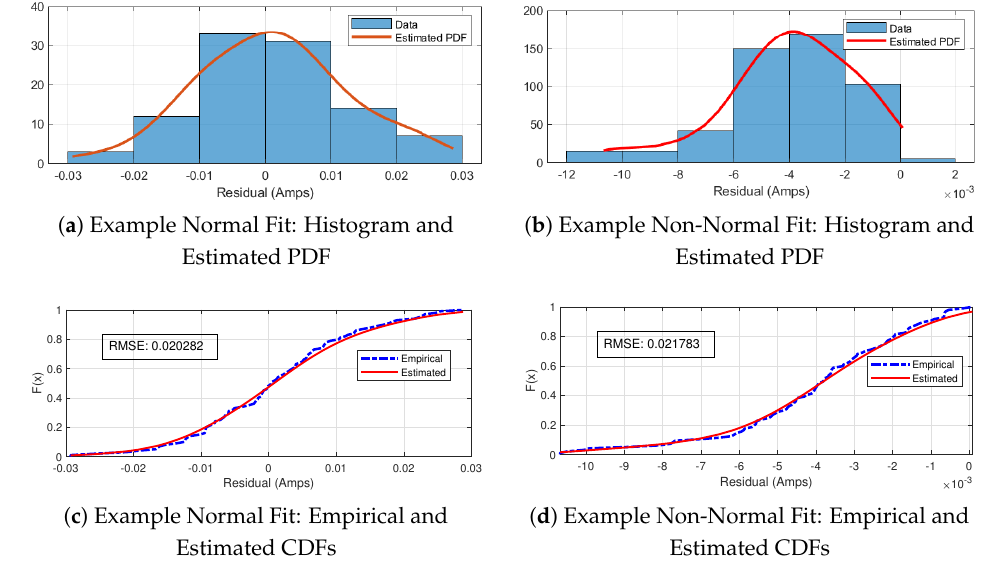
Figure 5. Normally distributed ( a , c ) estimated residual amplitude error for harmonic # 7 as seen by S 2 for the wind-fault transient event, and non-normally distributed ( b , d ) example harmonic #